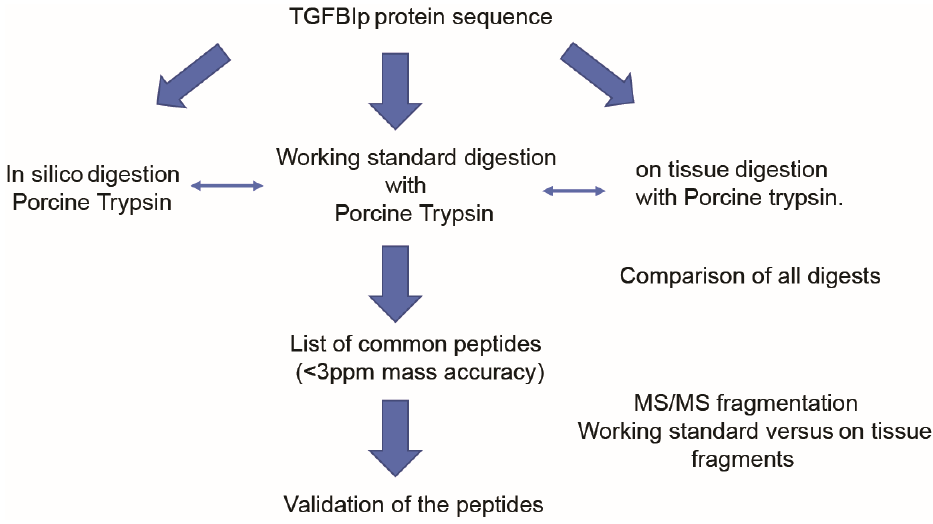
Figure 2. Process for method development to detect TGFBIp in the corneal samples (process chart).